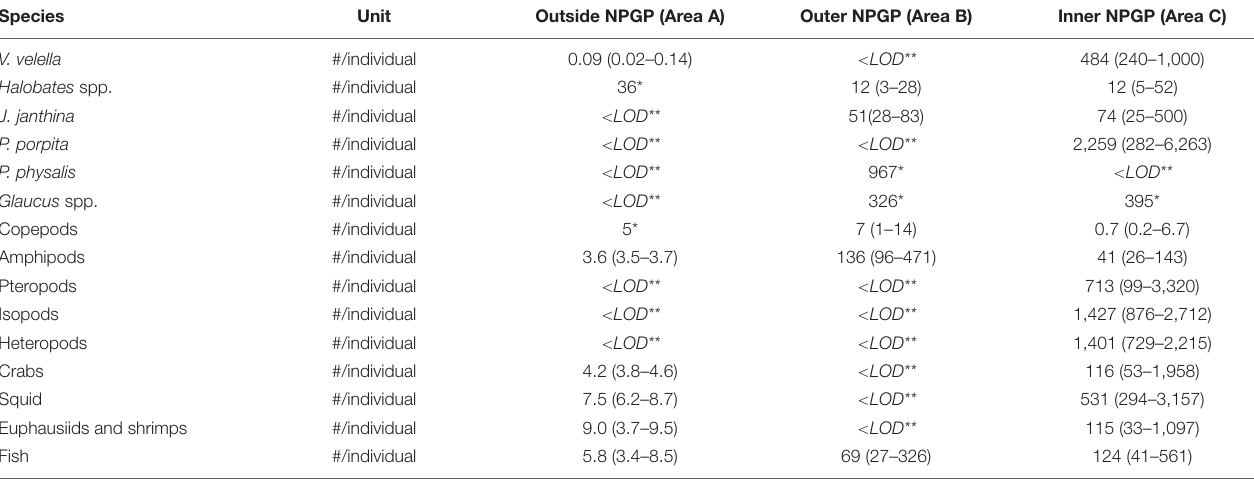
TABLE 2 | Numbers (#) of plastic pieces (0.05–5 cm in size) present per individual of different members of the neuston observed in the eastern North Pacific